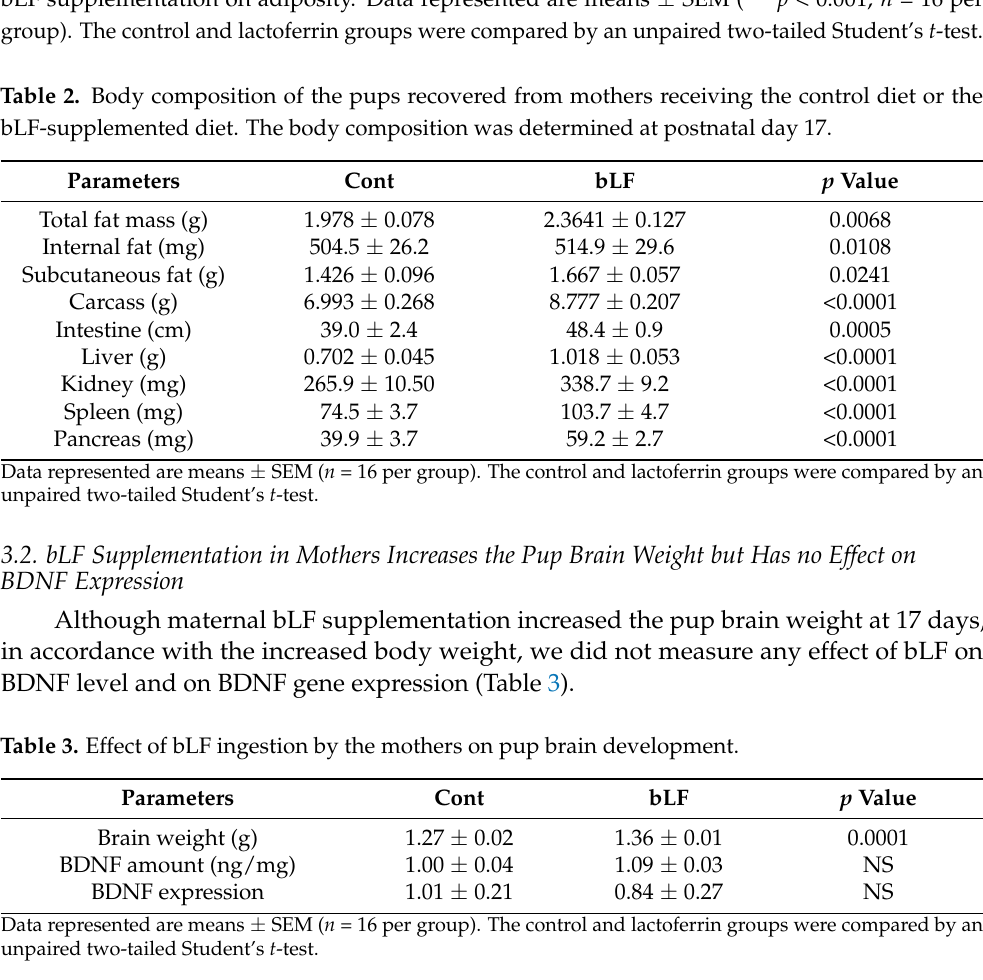
Table 3. Effect of bLF ingestion by the mothers on pup brain development.